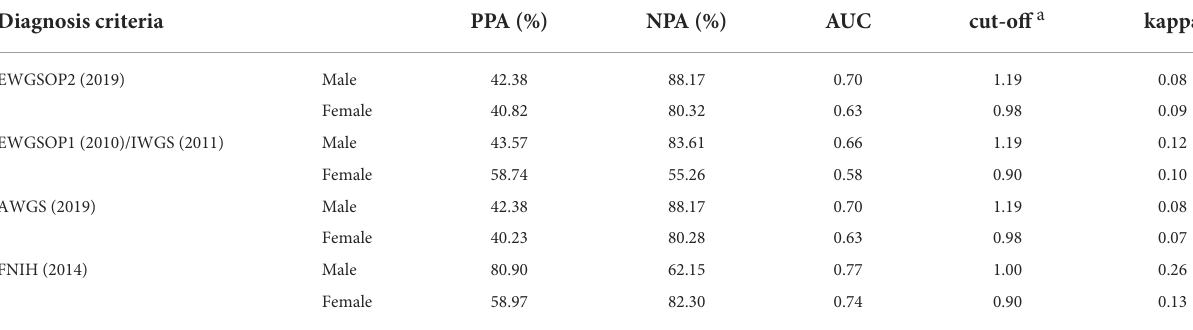
TABLE 3 Agreement comparison of Cr/CysC criteria with other diagnosis criteria for low muscle mass